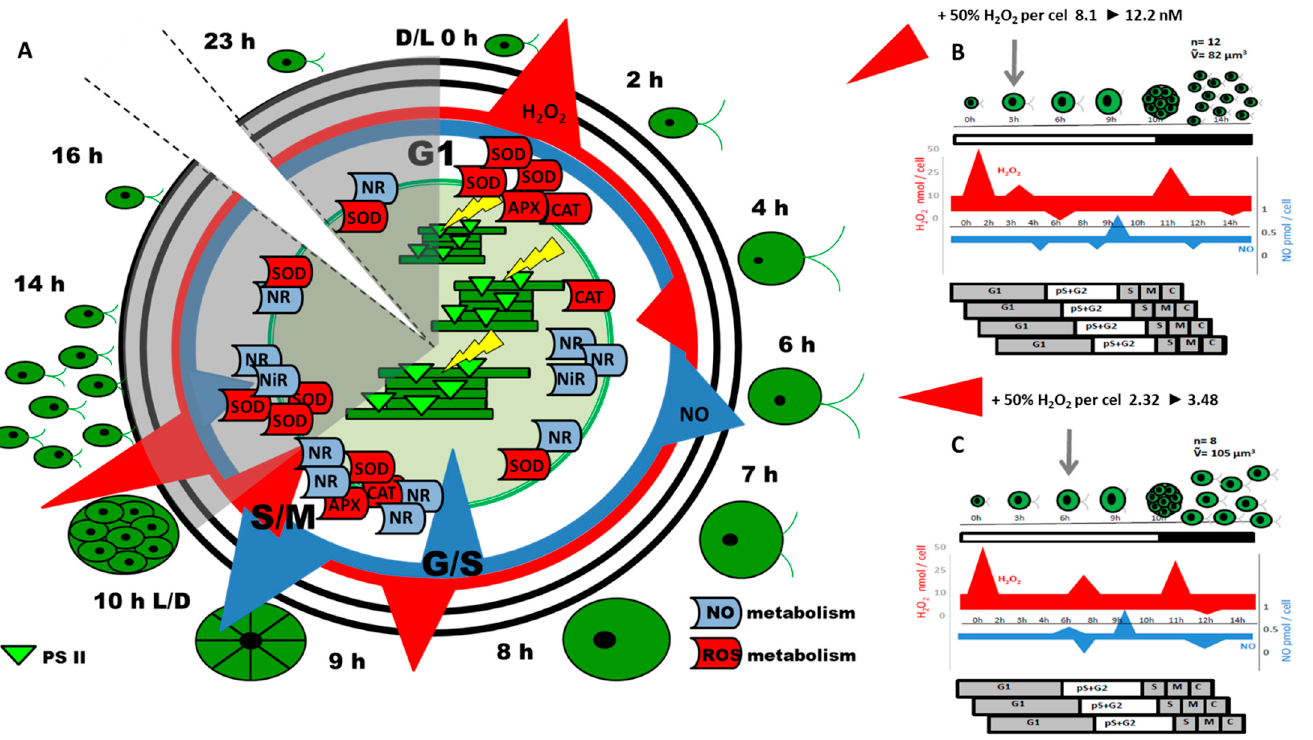
Figure 1. The overall plot of events during the cell cycle of Chlamydomonas reinhardtii under control conditions ( A ) and after exogenous application of H 2 O 2 to a suspension of synchronously growing cells in the selected moments of the cell cycle: 3rd h of the light period ( B ) and 6th h of the light period ( C ). The time of H 2 O 2 application to the culture is indicated by arrows. White areas indicate the light cell cycle period, while shaded ones represent the dark period. Changes in H 2 O 2 and NO level during the light and dark periods are shown as triangles, where figures size and orientation represent the trends in the H 2 O 2 and NO level changes during the cell cycle duration. Schematic pictures of the cells indicate their increasing size during the cell cycle and small circles with black dots inside illustrate the zoospores with cell nuclei arising within one mother cell. The average number (ñ) and the average size (V) of zoospores released from the mother cell in the dark phase of the cell cycle are indicated by numbers. Modified from [5,26]. Legend to Figure 1. APX–ascorbate peroxidase; CAT–catalase; D–darkness; L–light; NiR–nitrite reductase; NO–nitric oxide; NR–nitrate reductase; SOD–superoxide dismutase; G1,2, S, M, C–cell cycle phases: Growth, Synthesis, Mitosis, Cytokinesis.